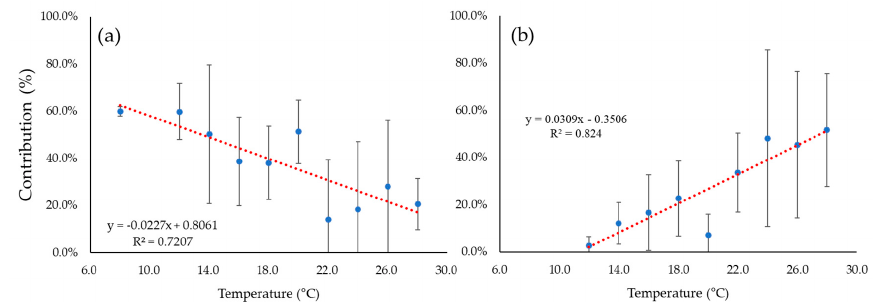
Figure 5. Relationships between contributions of two major phytoplankton communities and water temperature for all the cruise period, 2018. ( a ) Diatom ( b ) Cyanobacteria.